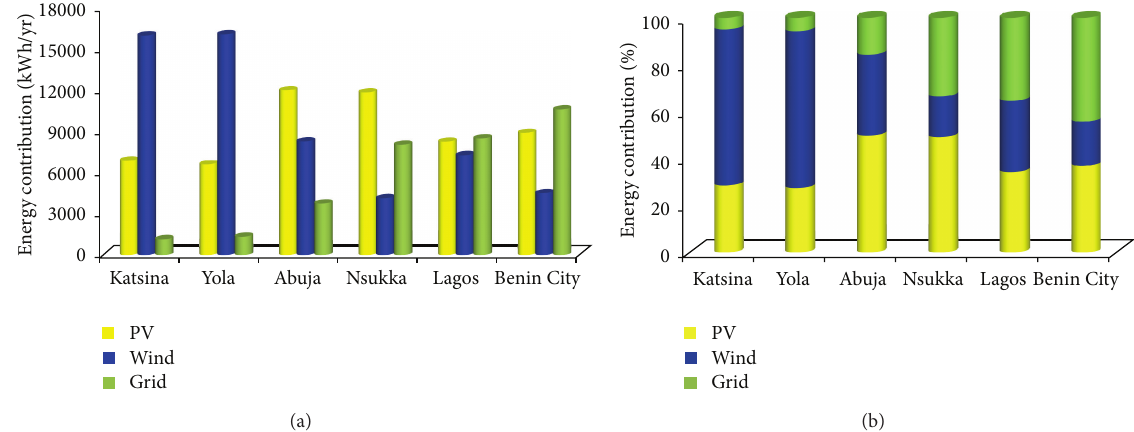
Figure 7: Electrical characteristic of proposed hybrid energy system: (a) energy contribution and (b) percentage contribution.